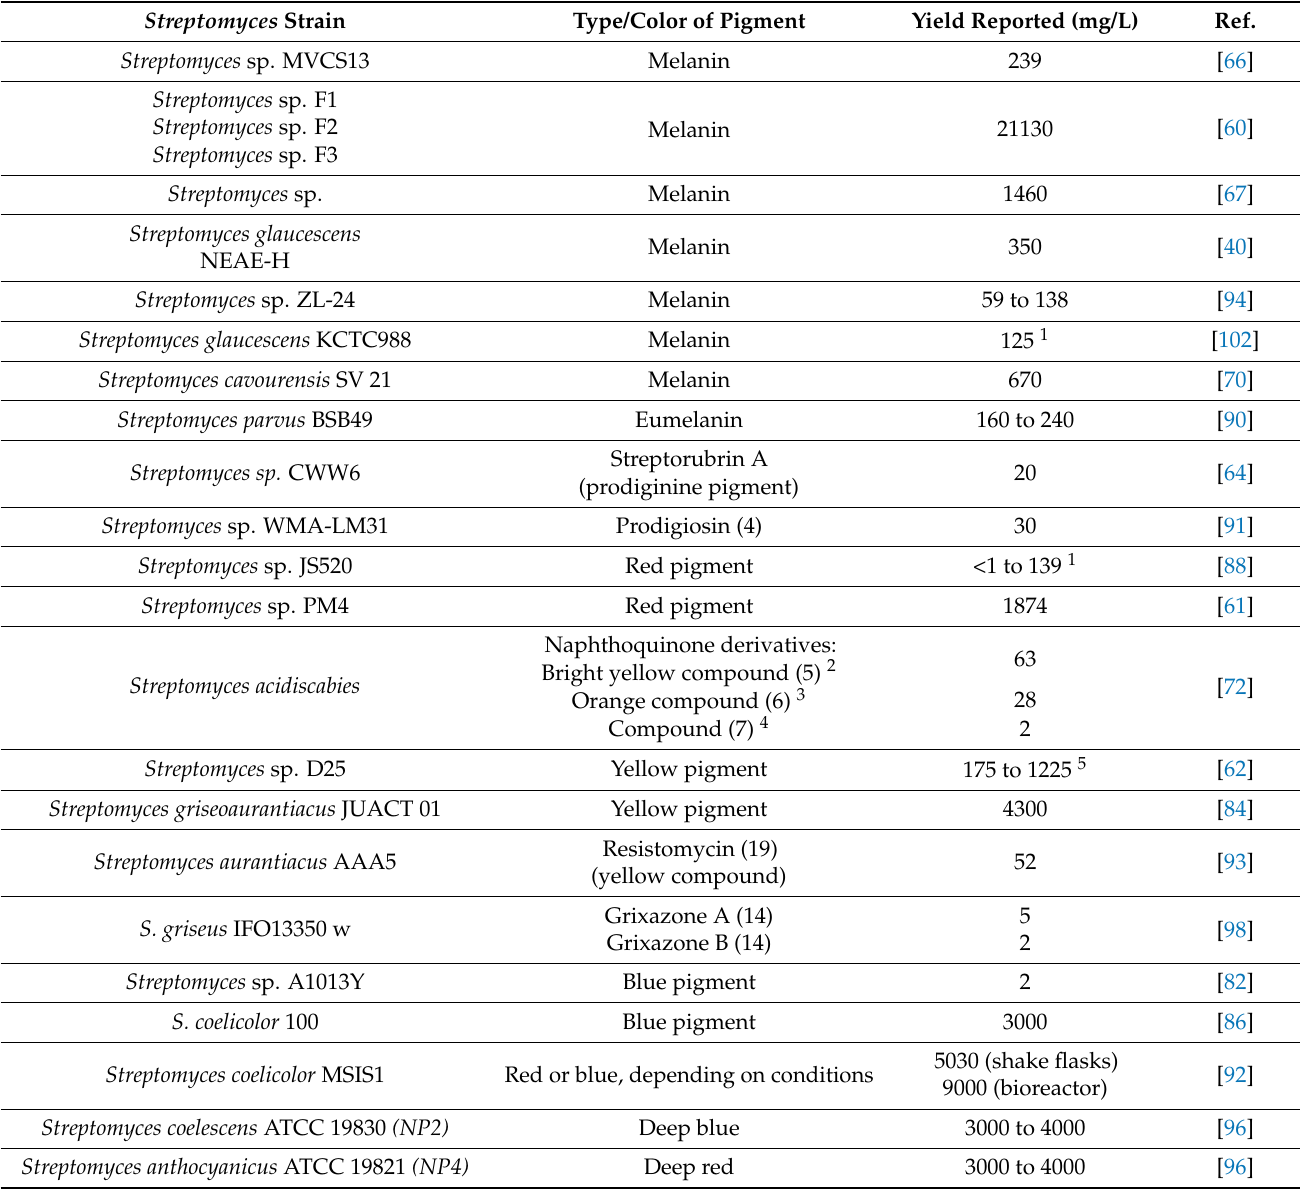
Table 2. Yield reported for each type of pigment and the Streptomyces strain that produces